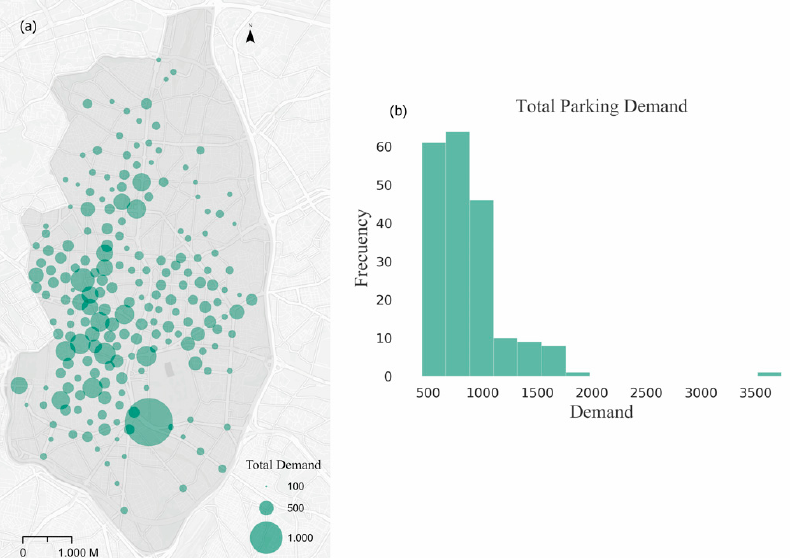
Figure 6. ( a ) Reference scenario: optimal location of parking spaces based on the total origins of the trips. ( b ) Covered demand distribution by parking places.